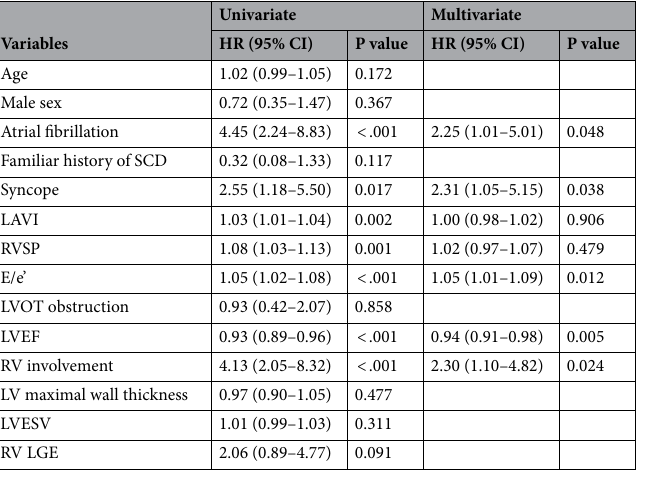
Table 2. Univariate and multivariate Cox proportional hazard models for primary outcomes in total study population (n = 256). SCD sudden cardiac death, LAVI left atrial volume index, RVSP right ventricular systolic pressure, LVOT left ventricular outflow tract, RV right ventricle, LV left ventricle, LVEF LV ejection fraction, CMR cardiac magnetic resonance, LVESV left ventricular end systolic volume, LGE late gadolinium